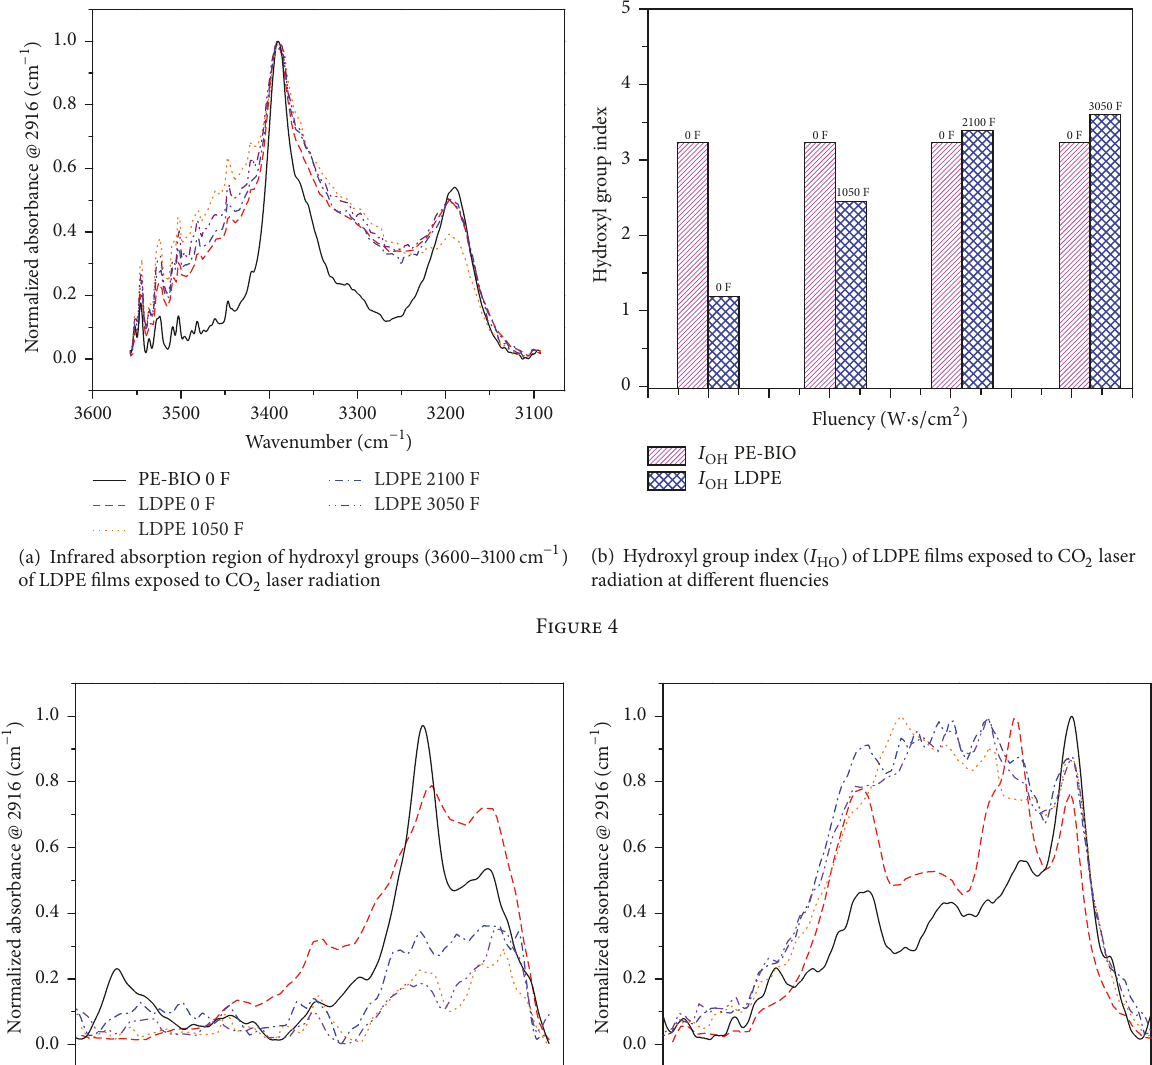
(a) Infrared absorption region of vinyl functional group of LDPE films exposed to different fluencies